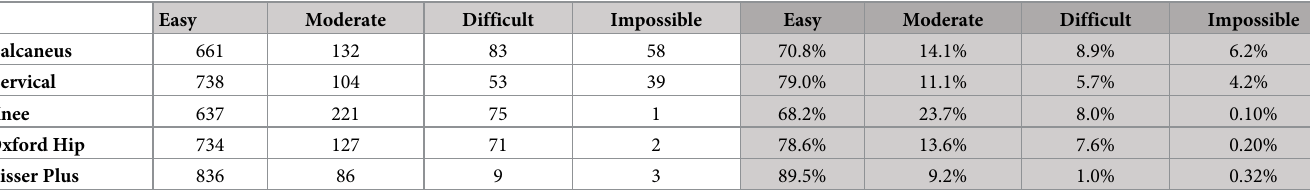
Table 2. Difficulty of evaluation with each bone age method.